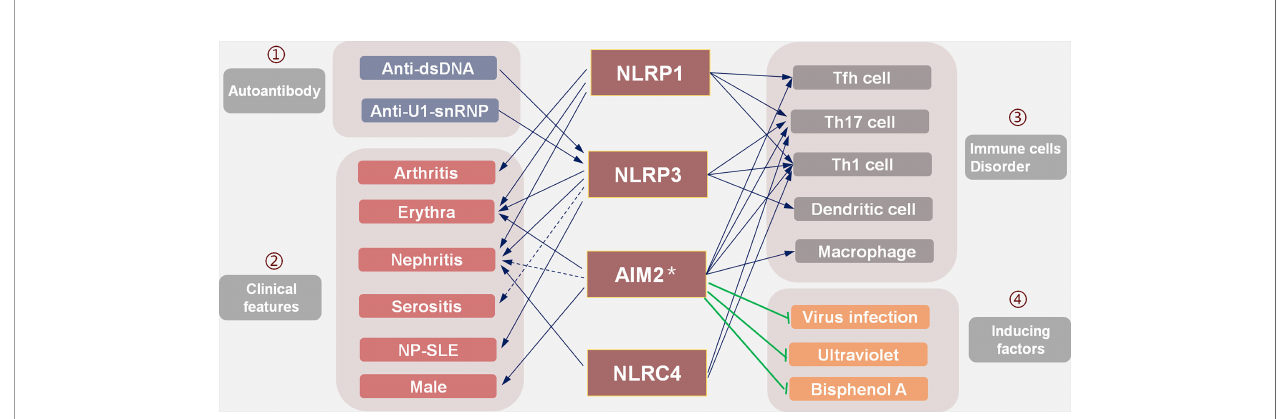
FIGURE 3 | The selection strategies of targeted in fl ammasome inhibitors in SLE: existing evidence suggests that (1) in fl ammasomes mediate the pathogenicity of autoantibodies; (2) different organ damage is related to the activation of corresponding in fl ammasomes; (3) in fl ammasomes affect the differentiation and proliferation of immune cells and participate in SLE; (4) induced factors such as viral infection, ultraviolet rays, and BPA all play a role through IFN-I, while the AIM2 in fl ammasome may play a protective role. In the selection of in fl ammasome inhibitors, many factors should be considered to screen out the in fl ammasome that plays the main pathogenic